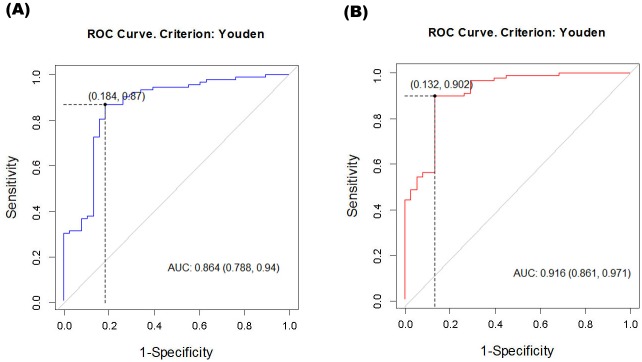
Receiver operating characteristic (ROC) curves of two models extracted from multivariate logistic regression.(A) PdetQmax, Qmax (B) PdetQmax, Qmax, ΔPabd.